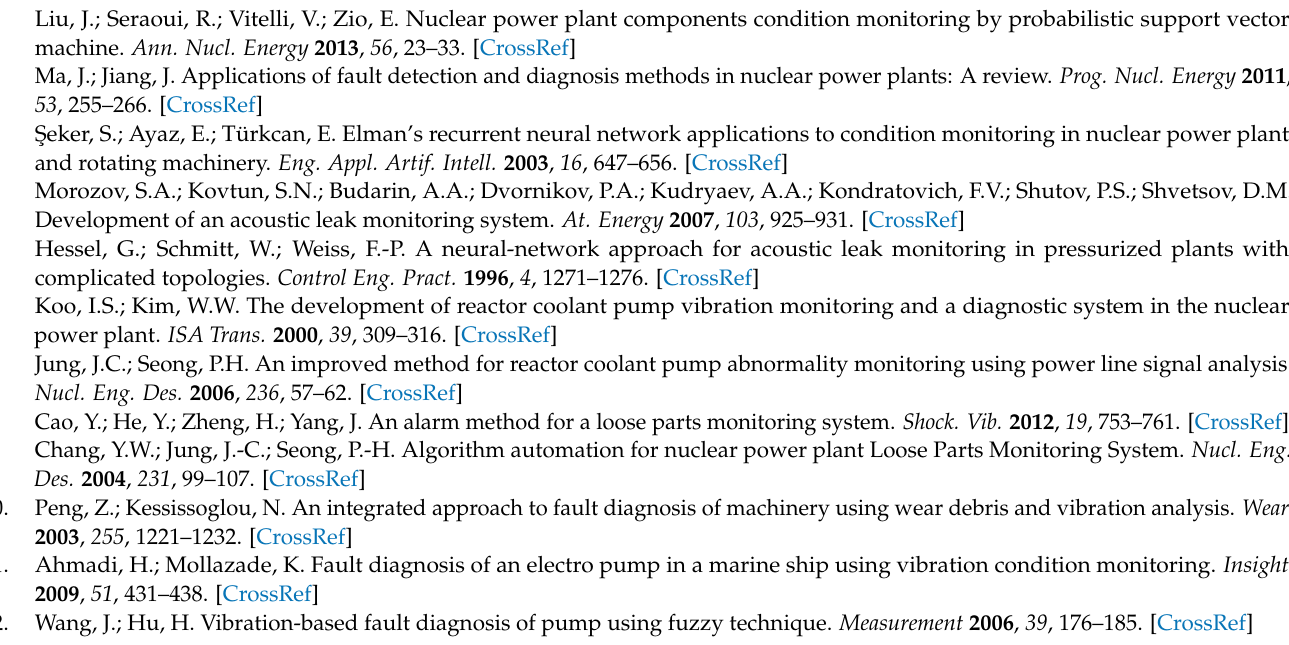
Figure S2: Figure S2. Power densities of the PVV sensors at the resonant frequencies as a function of load resistance, Video S1: PVV sensors